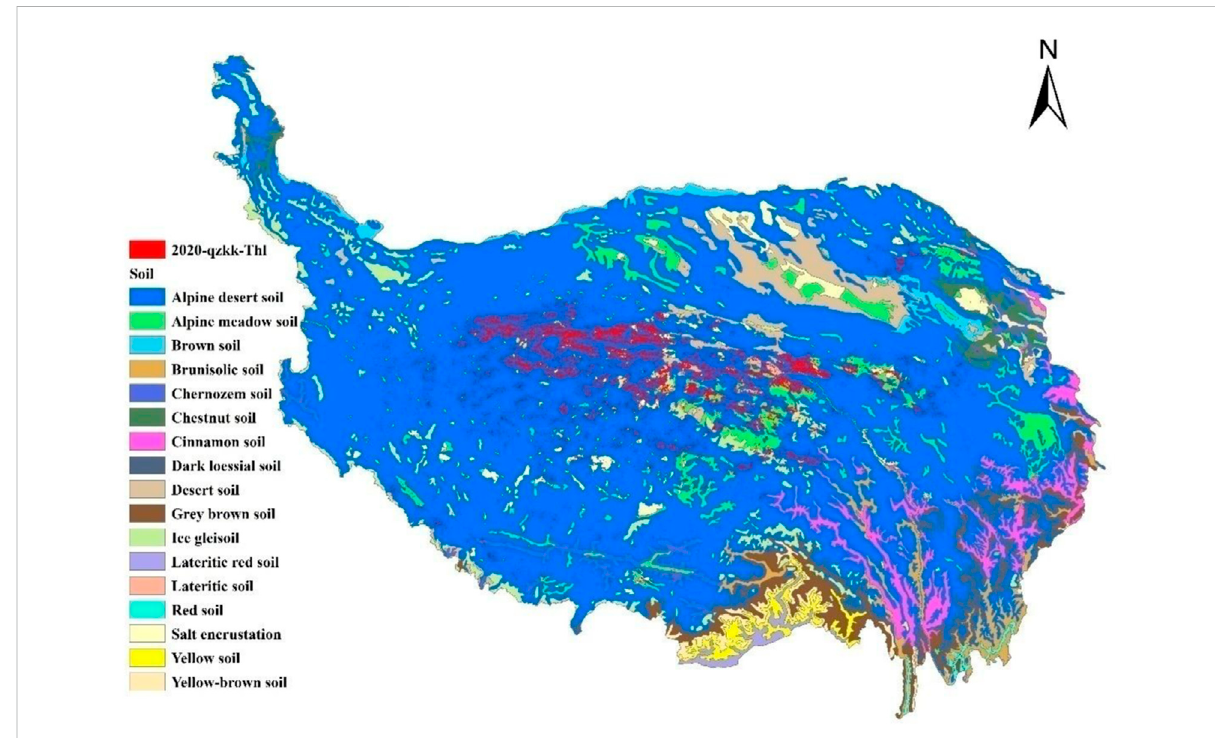
FIGURE 8 Annual mean precipitation of the QTP, 1980 –